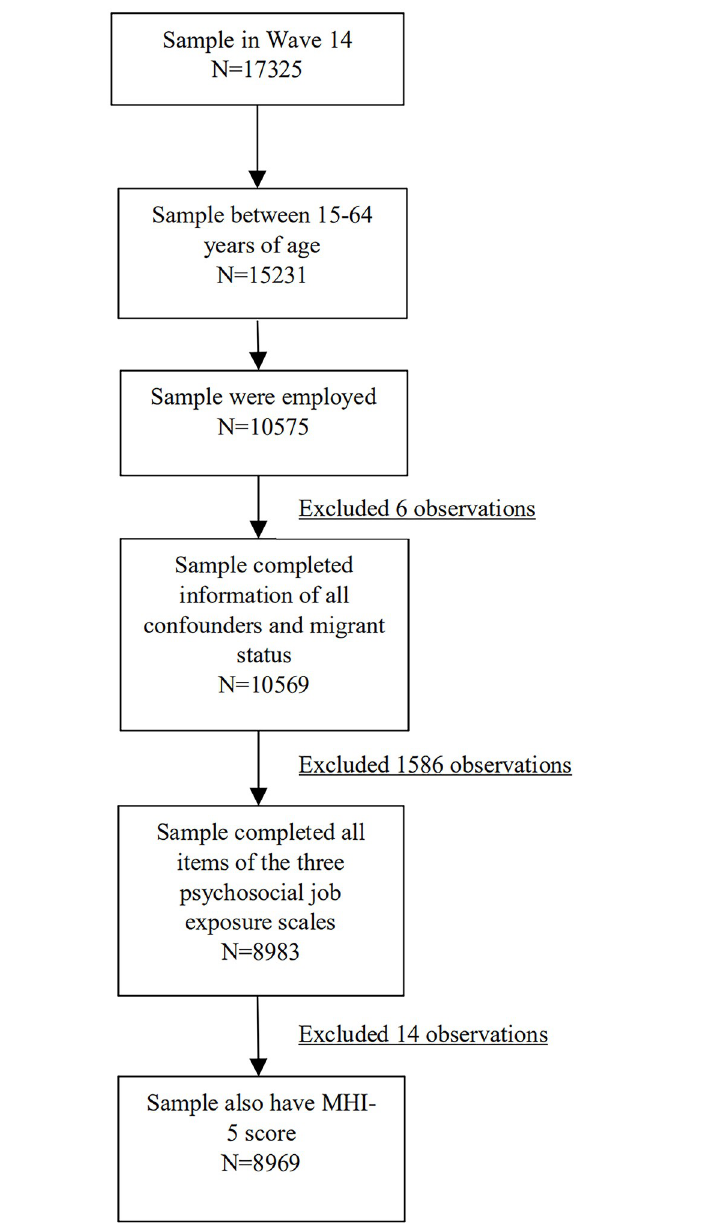
Fig 1. Participant flow into the analytic